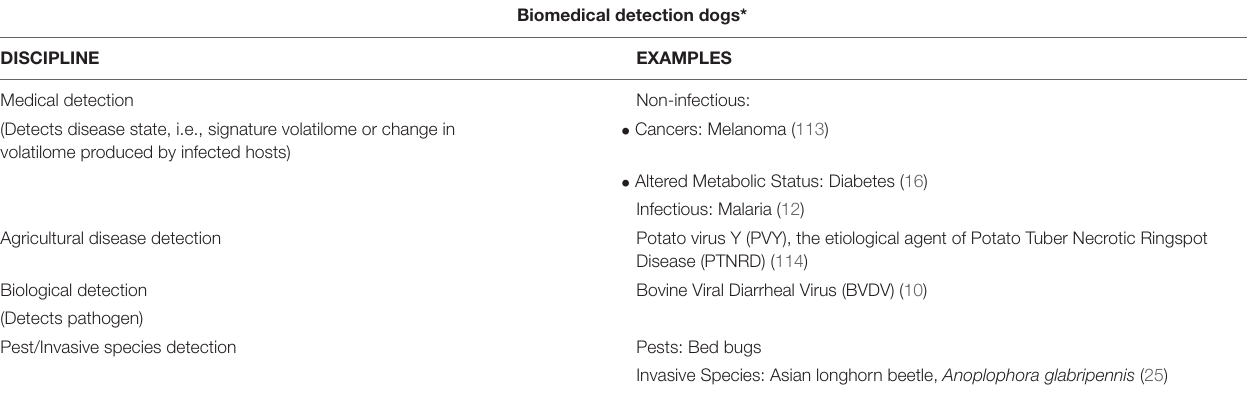
TABLE 2 | Subdisciplines within the biomedical detection dog field and examples of the diseases/pathogens/pests they